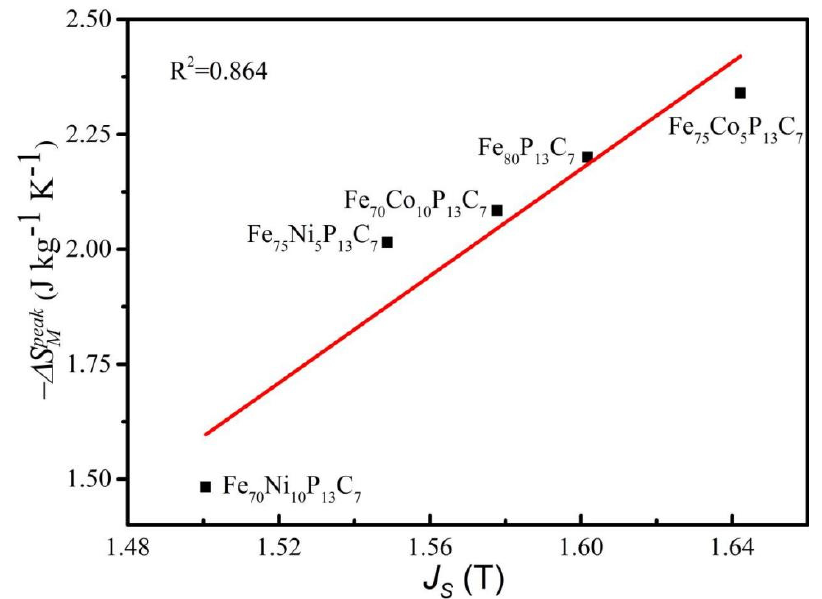
Figure 7. The relationship between saturation magnetization ( J s ) at room temperature and the maximum magnetic entropy changes ( glassy alloy rods at a magnetic applied field of 1.5 T.